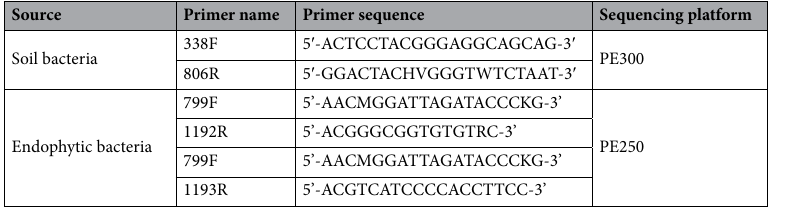
were collected separately from the plant using sterilized scissors and placed in sealed sterile bags and labeled. i.e., soil and appendages were rinsed from the surface of the samples with sterile water and blotted dry with sterile filter paper. The stems were placed in sterile bags and stored at − 80 ℃ for endophytic bacterial compositions analysis.